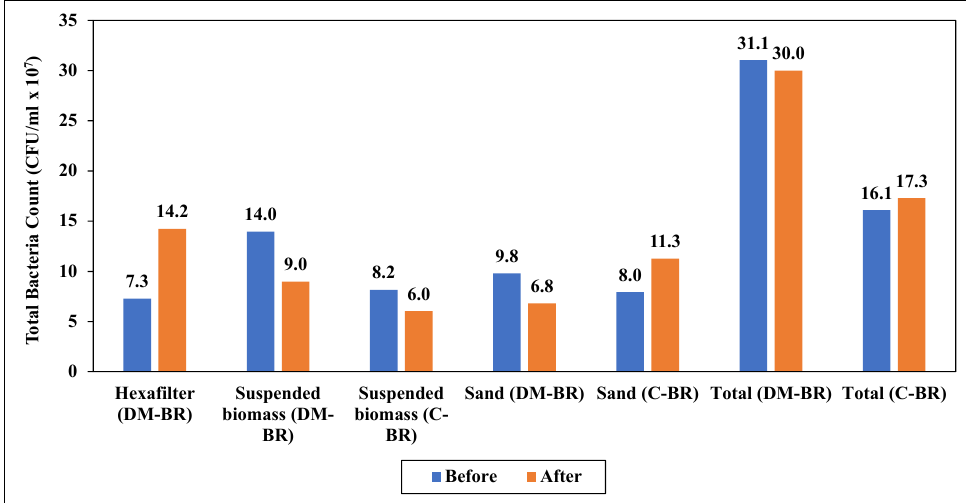
Figure 6. Total bacterial count for samples before (day 97) and after treatment (day 173).